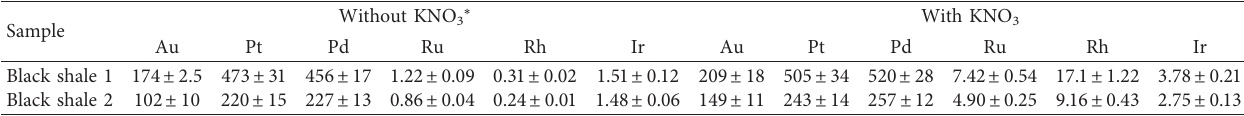
Table 3: The analytical results of different pretreatment procedures for black shale (ng · g − 1 ). Sample